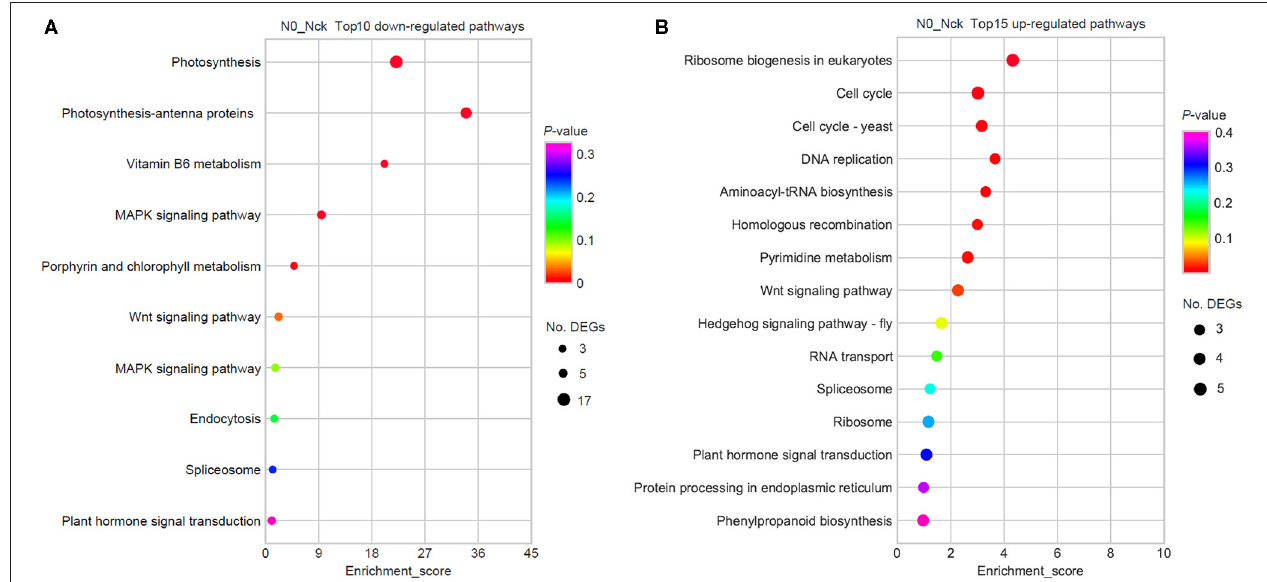
FIGURE 4 | KEGG enrichment pathways by the DEGs. (A) Top 10 down-regulated pathways. (B) Top 15 up-regulated pathways. The x-axis is the enrichment score, which reflects the proportion of DEGs in a given pathway. The circle size indicates the number of DEGs in the pathway, and the larger circle is comprised of more DEGs. The bubble color changes from purple to blue, green, and red; and the smaller the enrichment P -value, the greater the statistical